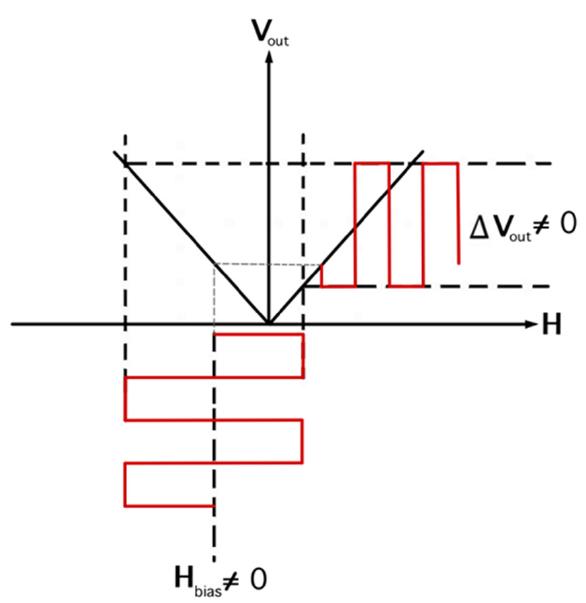
Figure 4. The voltage output as a function of the applied magnetic field when H bias ≠ 0. Table 2. Terfenol–D, Cr 2 O 3 , and PtMn